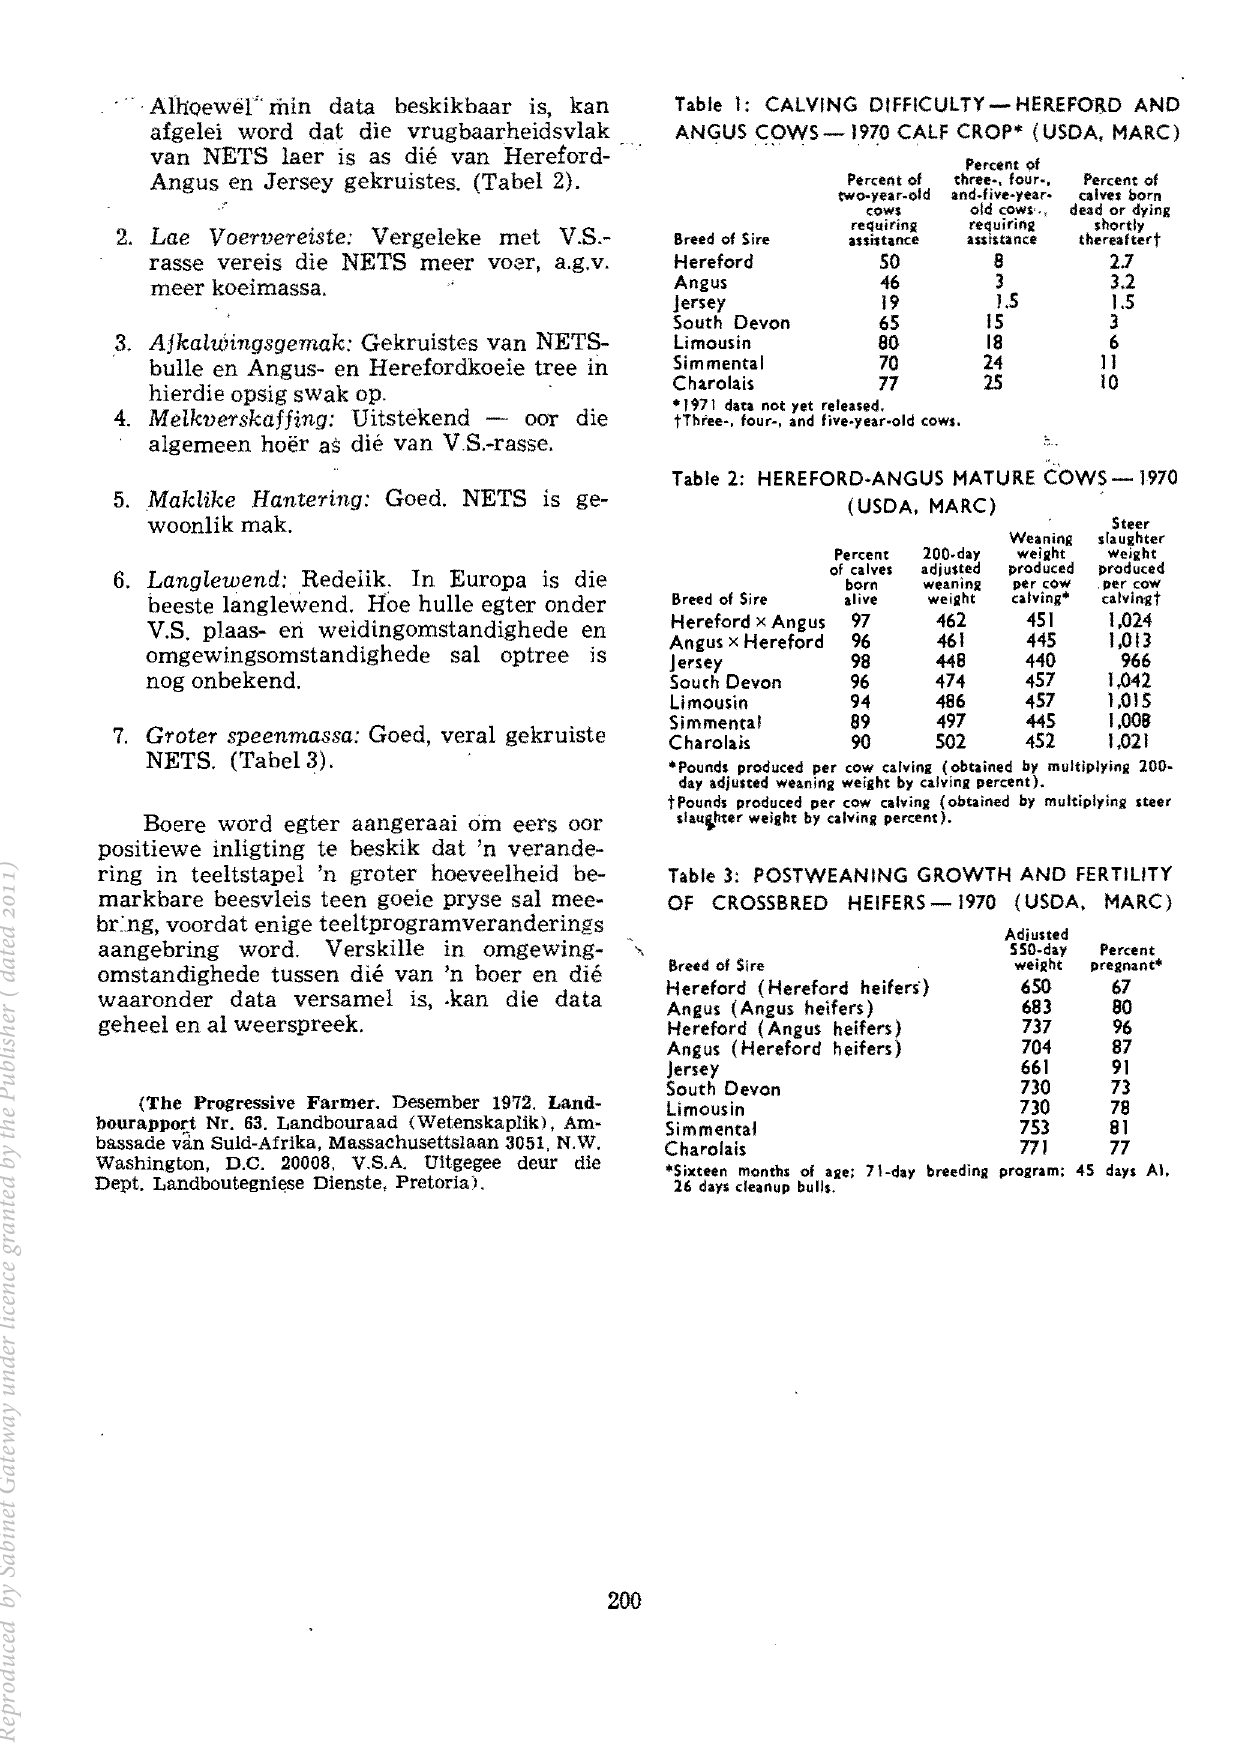
Table 2; HEREFORD-ANGUS MATURE COWS-1970